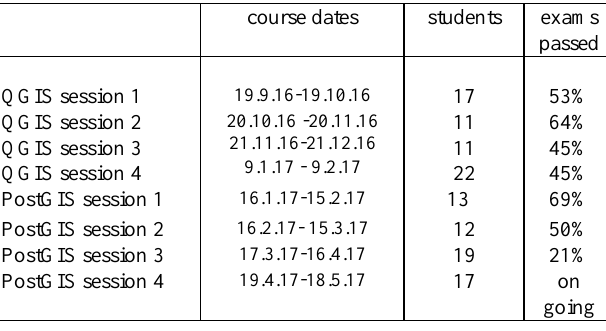
Table 1. Summary of the online courses carried